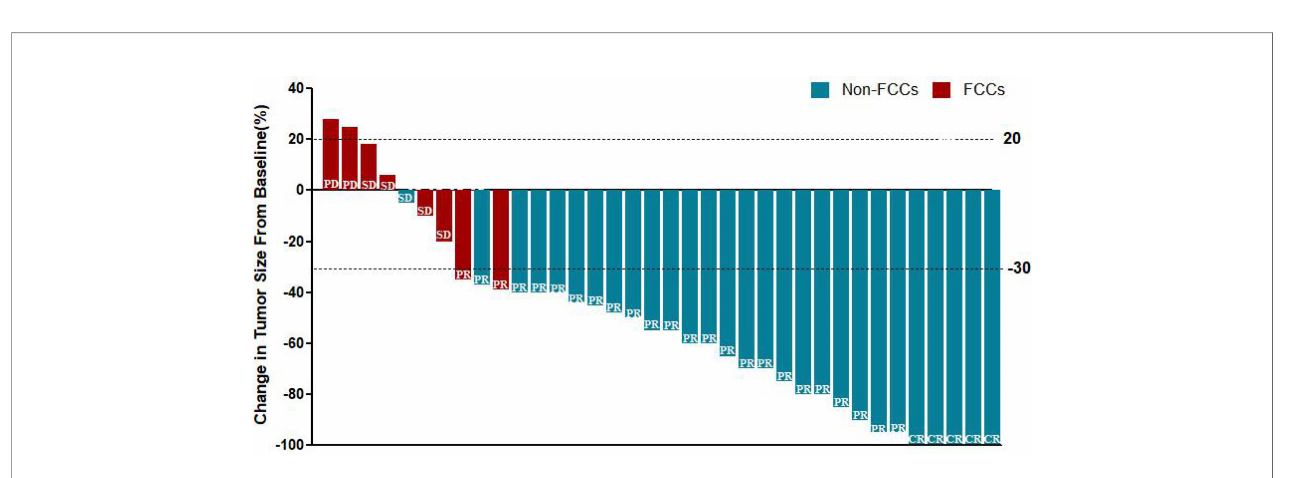
FIGURE 4 | ROC curves for discriminating patients with FCCs and those with non-FCCs according to values of the SII (a/c) and PNI (b/d) . (A, B) Before conversion therapy; (C, D) After 3 cycles of conversion